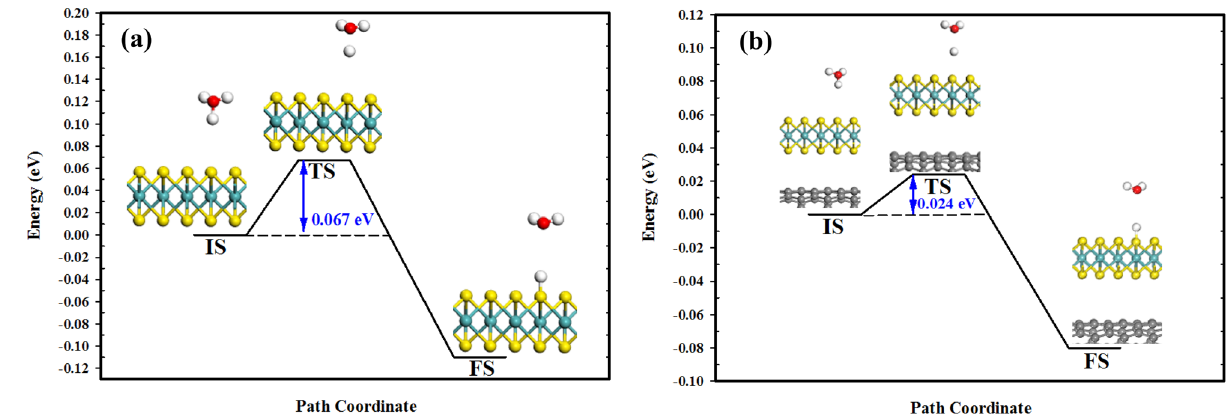
Figure 5. Minimum-energy pathway of the Volmer reaction on: ( a ) MoS 2 ; and ( b ) the MoS 2 /CNT heterostructure. IS, TS and FS stand for initial, transition and final states, respectively. BIOVIA, Dassault Systèmes, Materials Studio, version 7. https ://bit.ly/38lRR